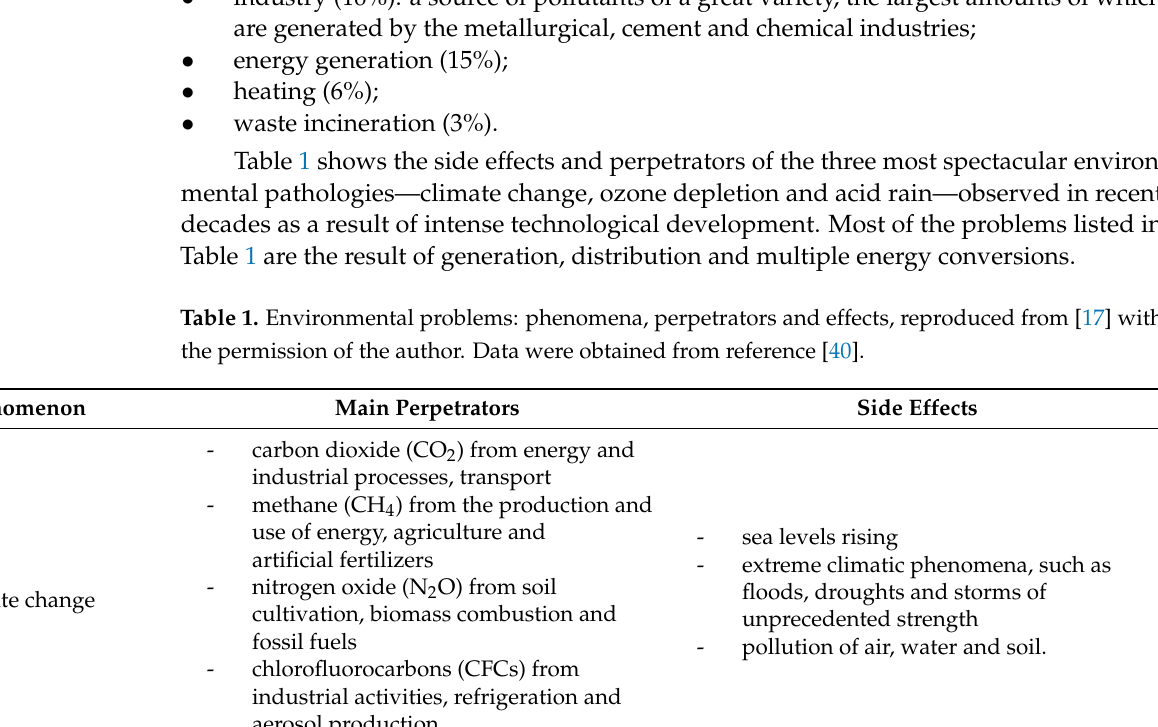
Table 1. Environmental problems: phenomena, perpetrators and effects, reproduced from [17] with the permission of the author. Data were obtained from reference [40].